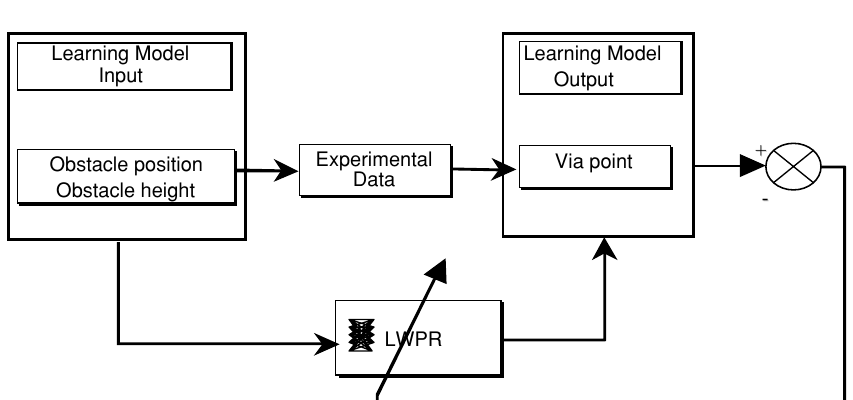
Figure 7 Algorithm for the via point position learning.